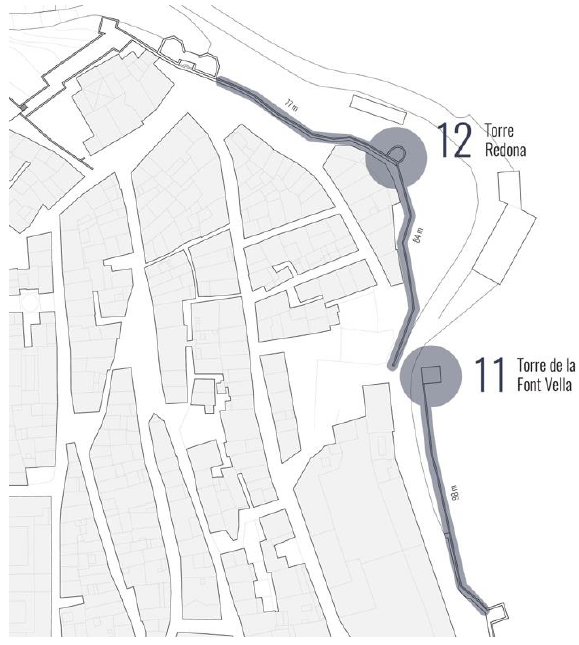
Figure 12. Section IV of the “Walls Walking Tour” (Source: Morella Town Council, modified by S. Portela,